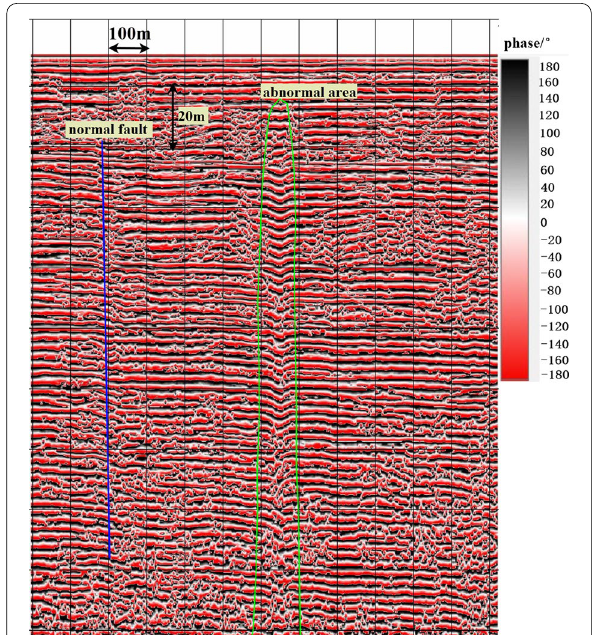
Fig. 9 Acoustic profile 2 in the survey area, and the seismic attribute is the phase for Fig. 7